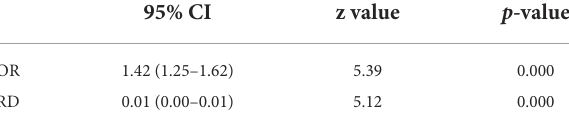
TABLE 3 Sensitivity